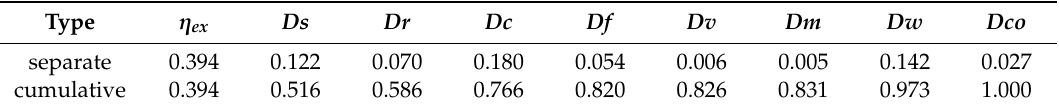
Table 3. Example data of separate and cumulative ratios of exergy consumption for x b = 40% and P f = 12